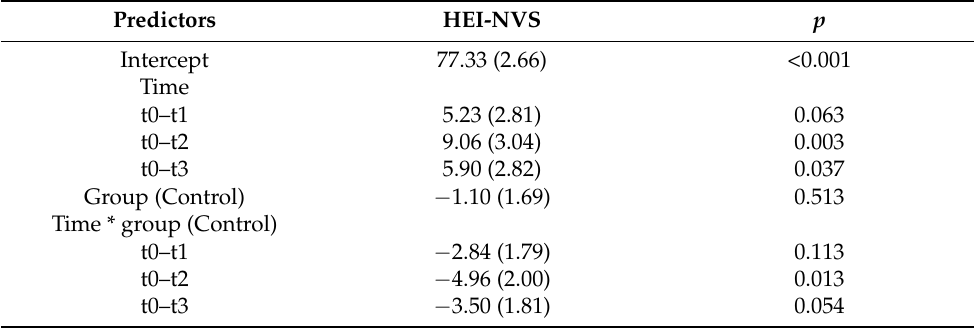
Figure 2. Mean and 95% confidence interval of the HEI-NVS for intervention ( n = 78) and control ( n = 75) (ITT analysis). Table 2. Results of the robust linear mixed model of the HEI-NVS (ITT analysis) 1 .